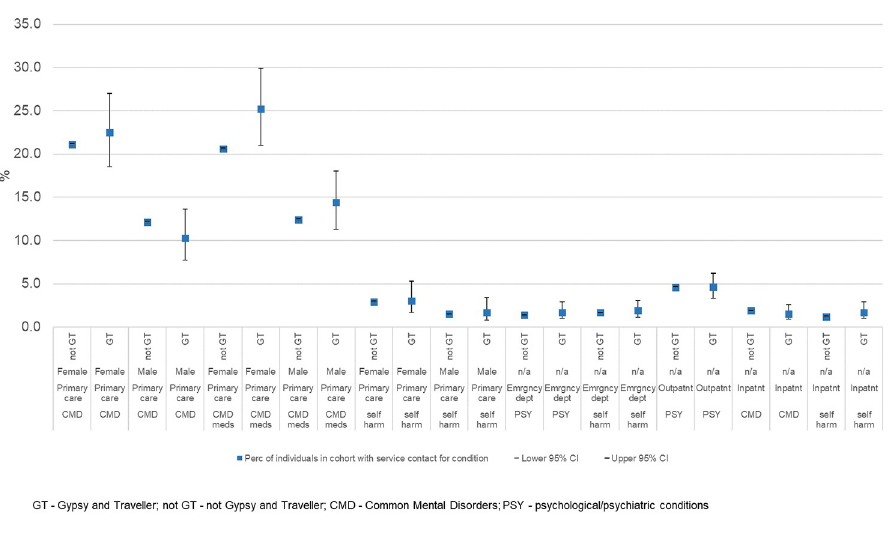
Fig 4. Observed unadjusted proportion with service contacts for conditions of